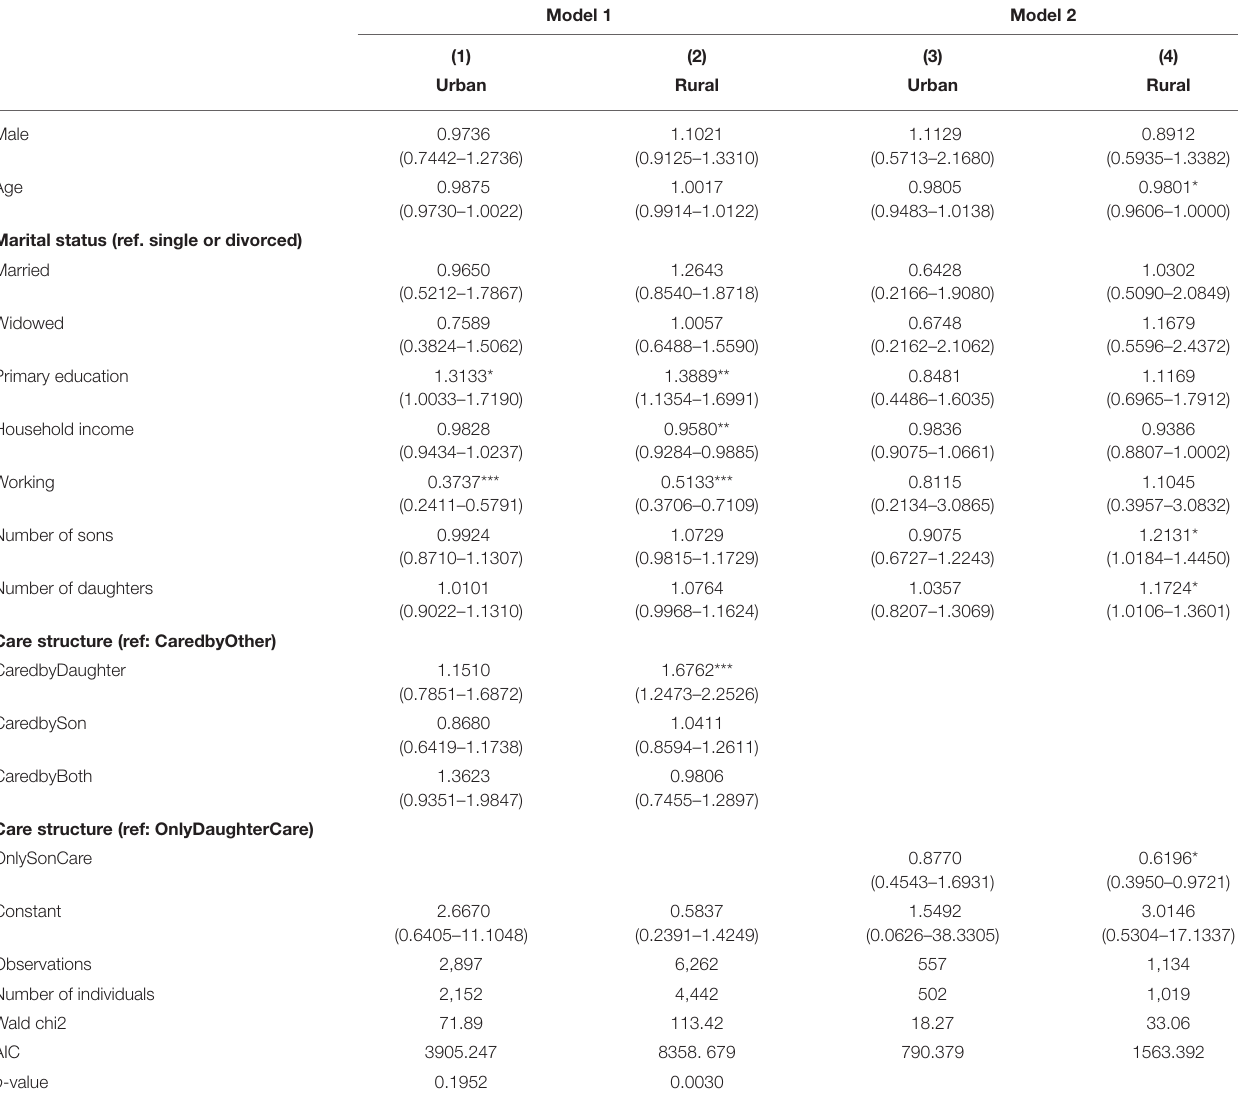
TABLE 4 | Radom-effects logistic regression models for self-reported health and care provided by son and daughter: differentiating by